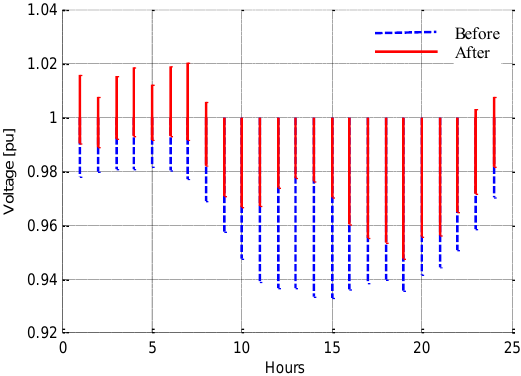
Figure 12. Voltage profile for 24 h (first scenario).